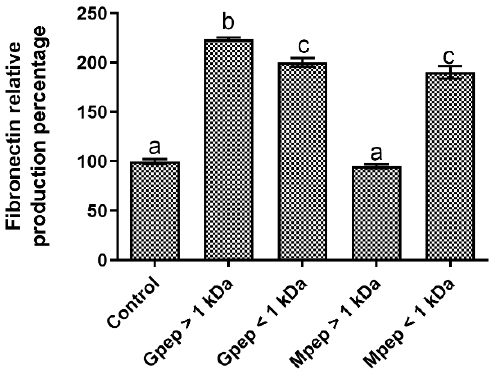
Figure 6. Fibronectin relative percentage of production in the presence of different peptide fractions relative to the basal level (control). Different letters represent the statistically significant differences ( p < 0.05) found between the samples tested.